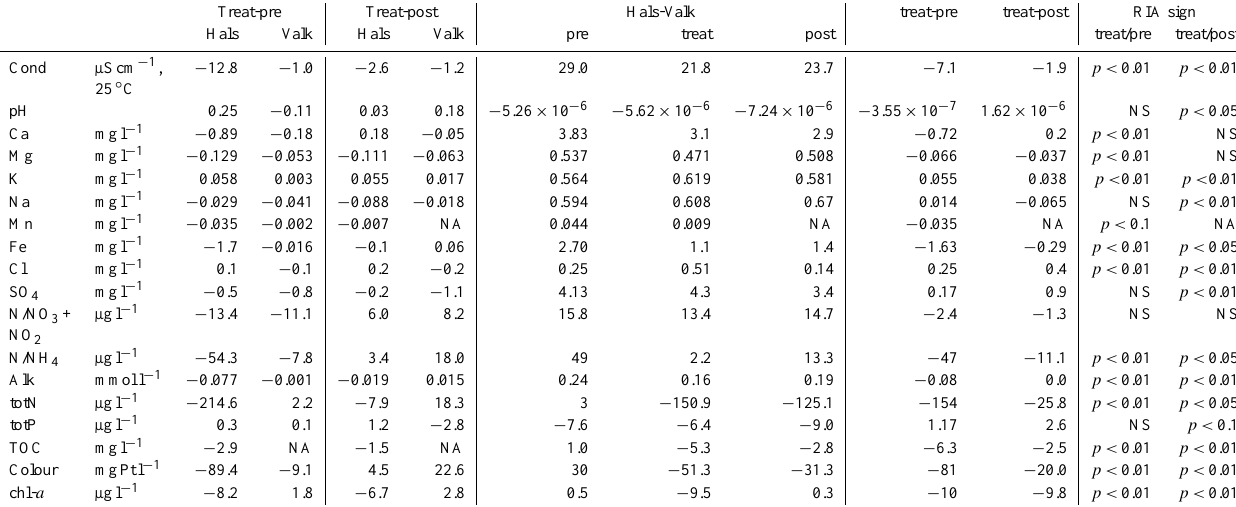
Table 3. Changes in chemical characteristics of lakes Halsj¨arvi (Hals, experimental lake) and Valkea-Kotinen (Valk, reference lake) in the treatment period (treat) compared with the pre- and post-treatment conditions. Values are whole-lake volume-weighted mean concentrations based on samples collected during the ice-free season in May to October each year. Pre-treatment (pre) 2003–2004; treatment 2005–2006 (treat); post-treatment 2007 (post). Also shown are differences in concentrations in Halsj¨arvi relative to Valkea-Kotinen (Hals-Valk, years 2004–2007 according to samples ordered for RIA analyses), and change in difference for the treatment (treat-pre) and post-treatment (treat- post) years. The change ascribable to treatment was tested by Random Intervention Analysis (RIA). The RIA was carried out using values only from 2004 for the pre-treatment period. Statistical significance: NS not significant; p < 0.1; p < 0.05; p < 0.01; NA not available. See Table 2 regarding number of samples and estimations made regarding missing